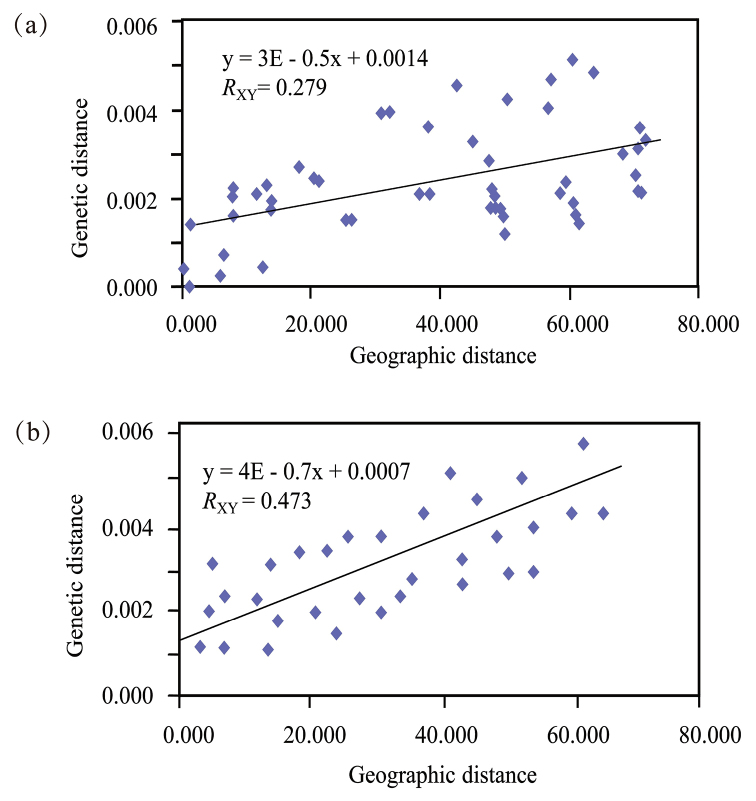
The results graph of the relationship between genetic and geographical distance for 12 populations based on the (a) ITS1/2 and (b) cpDNA